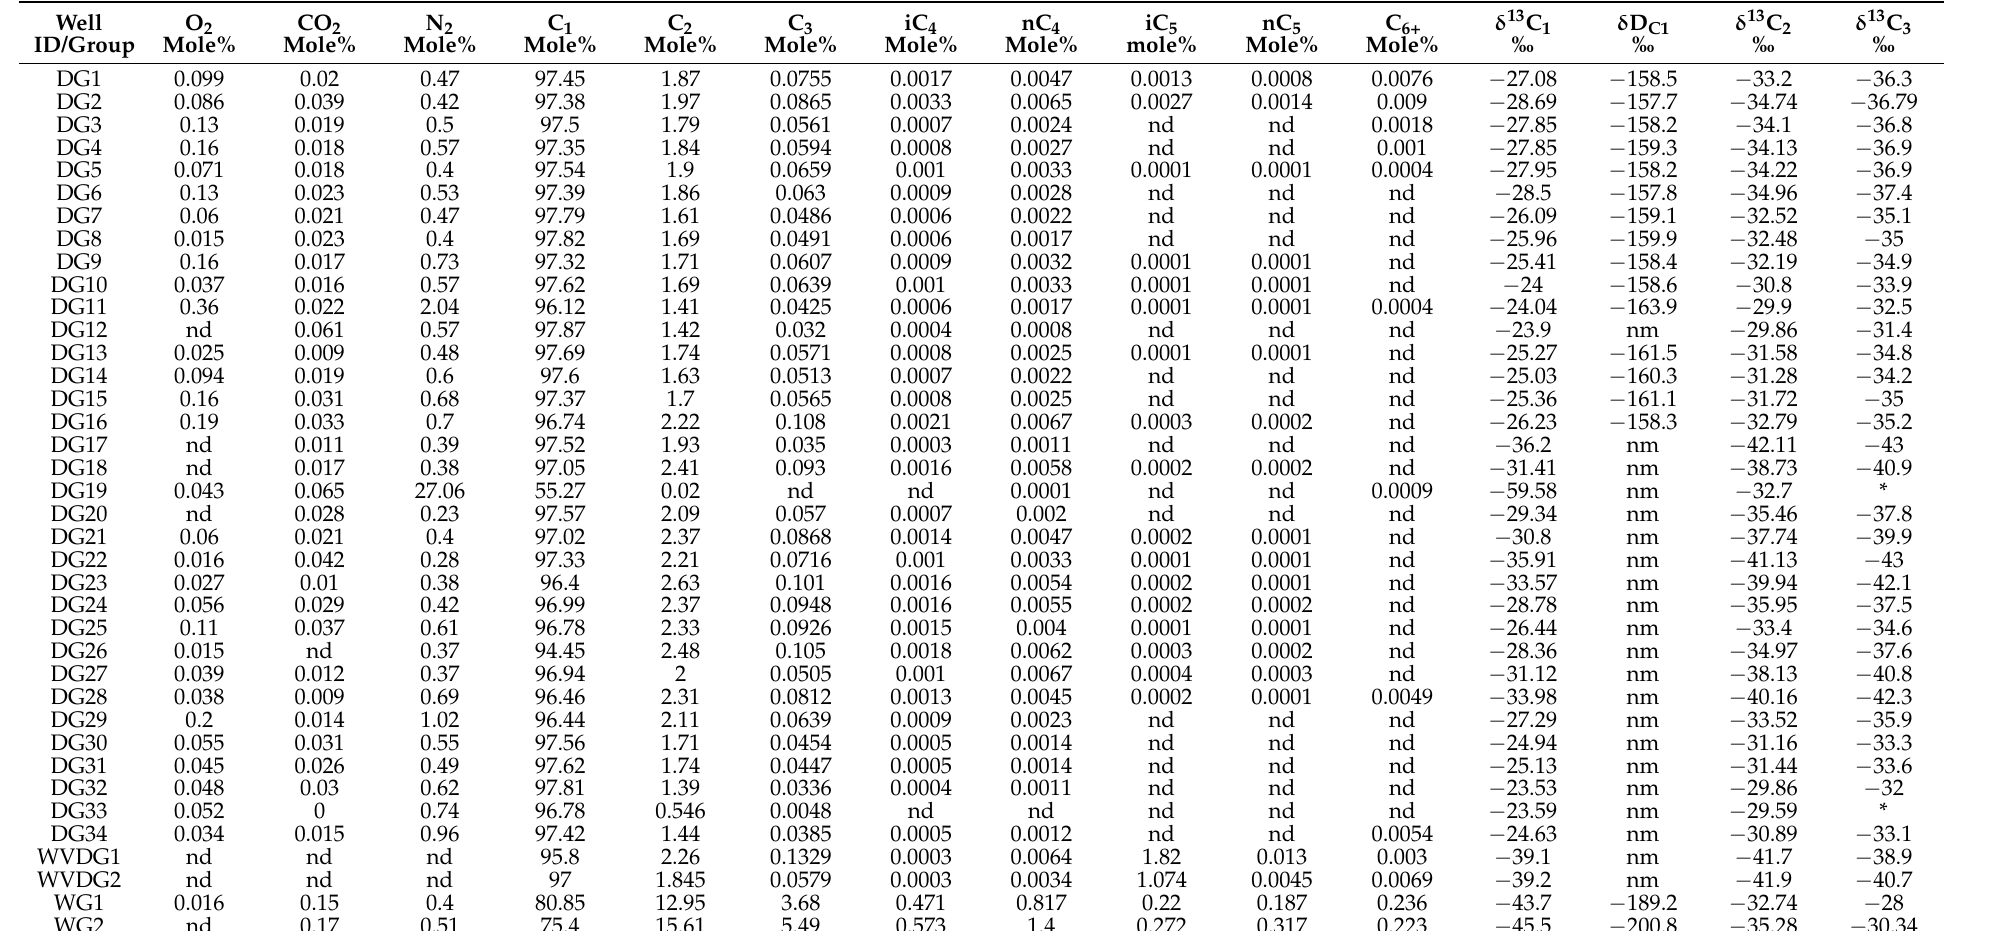
Table 1. Marcellus Formation produced gas samples, chemical composition, and isotope ratios. nd—not detected. nm—not measured. * Concentration too small to measure isotope compositions. Sample data in bold blue print are time-lapse data discussed in the text. DG—dry gas. WG—wet gas. WV—West